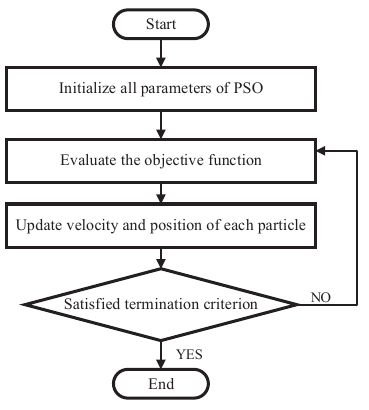
Figure 2. The basic process of